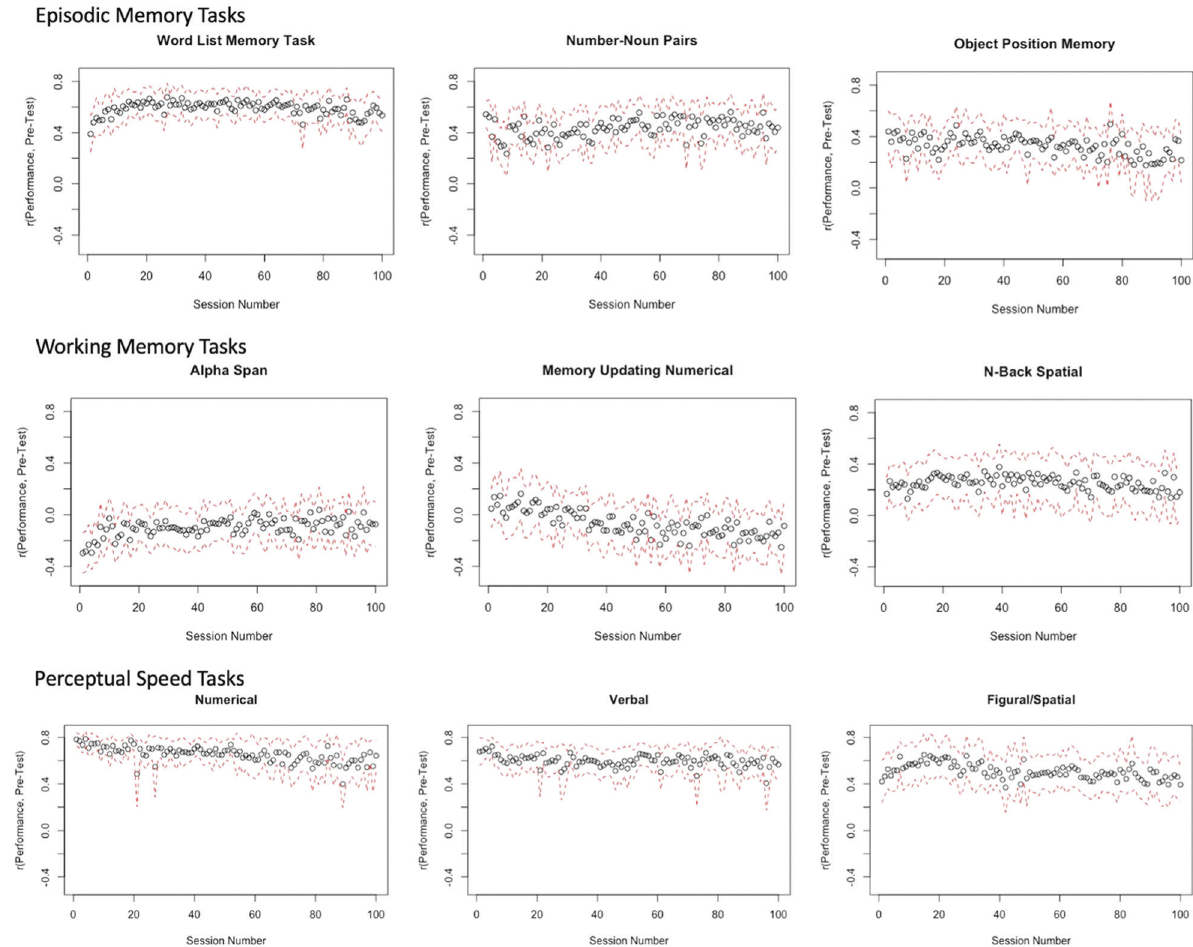
Fig. 2 Paneled plot of correlations between pre-test scores and performance on all cognitive tasks over the practice phase. The black circles indicate correlations between pre-test scores and performance, and the red dotted lines indicate 95% con fi dence